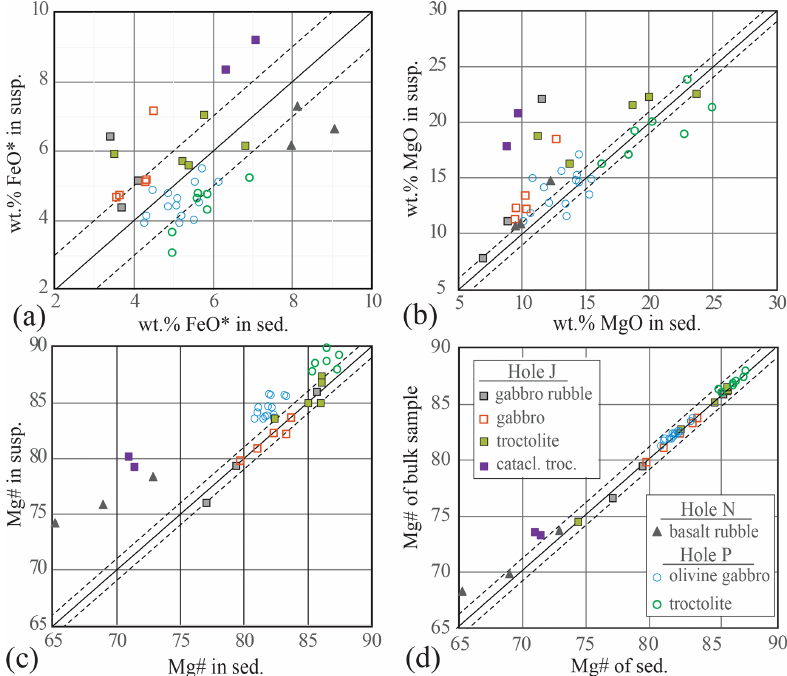
Figure 7. A comparison of the concentrations of MgO and FeO ∗ (total) in sedimented and suspended fractions of the channel samples. Solid line: 1 to 1, no fractionation. Dashed lines: ± 1% envelope. (a) Graph showing that there is no systematic fractionation of FeO ∗ between sedimented and suspended samples. (b) Graph showing that MgO tends to be fractionated into the suspended sample, reflecting the relatively high concentration of MgO-rich phyllosilicates. (c) The comparison of the Mg# between suspended and sedimented samples shows the effect of phyllosilicates raising the Mg# in the suspended sample. (d) Graph showing that the larger mass of the sedimented sample dominates the Mg# of bulk